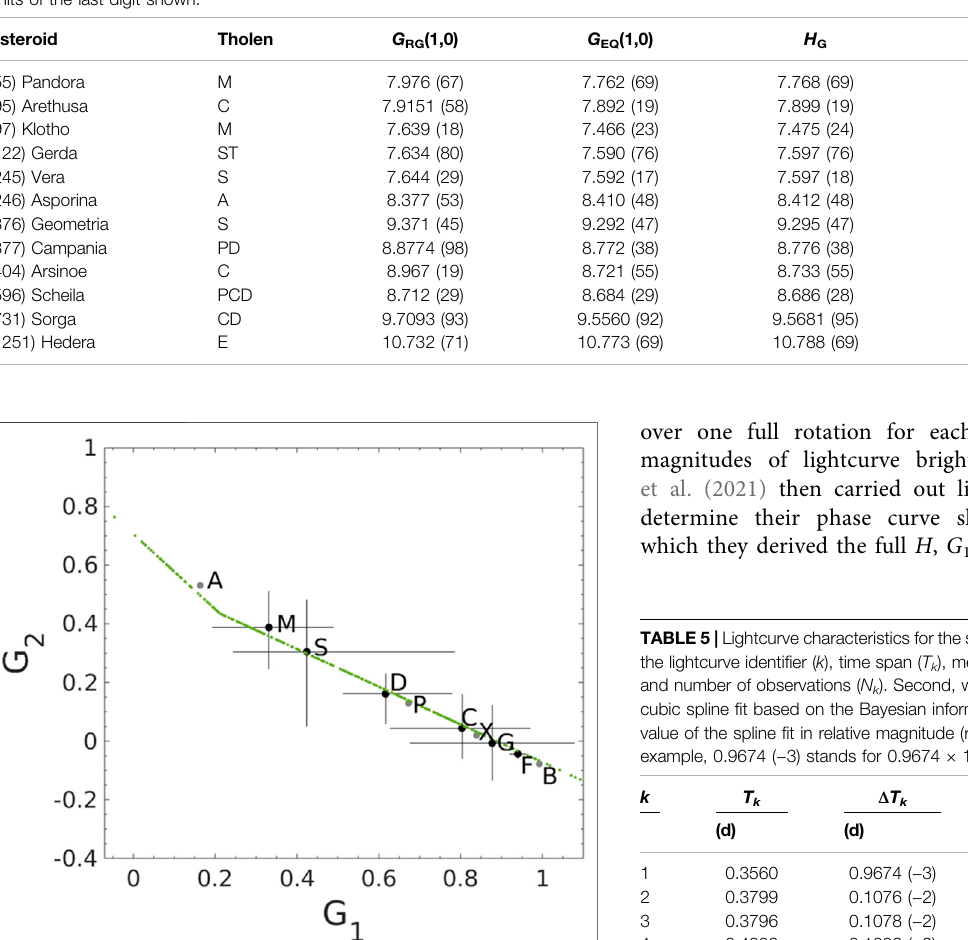
TABLE 3| TheTholenclasses,thederivedG-band absolutemagnitudes G RG (1,0)and G EQ (1,0)forthereferencegeometryand equal-spherecase, respectively,thederived absolute magnitudes H G using the H , G 1 , G 2 fi t, and the derived G 1 and G 2 parameters for the equal-sphere photometric phase functions. The uncertainties are given in units of the last digit shown.